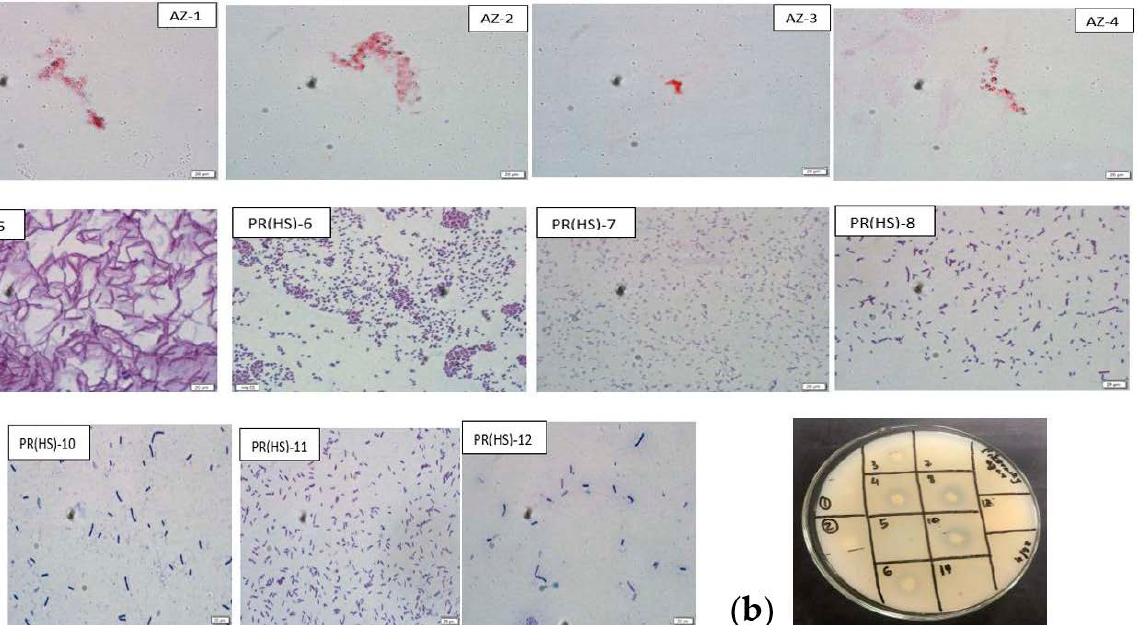
Table 1. Morphological studies and Gram staining of bacterial isolates.